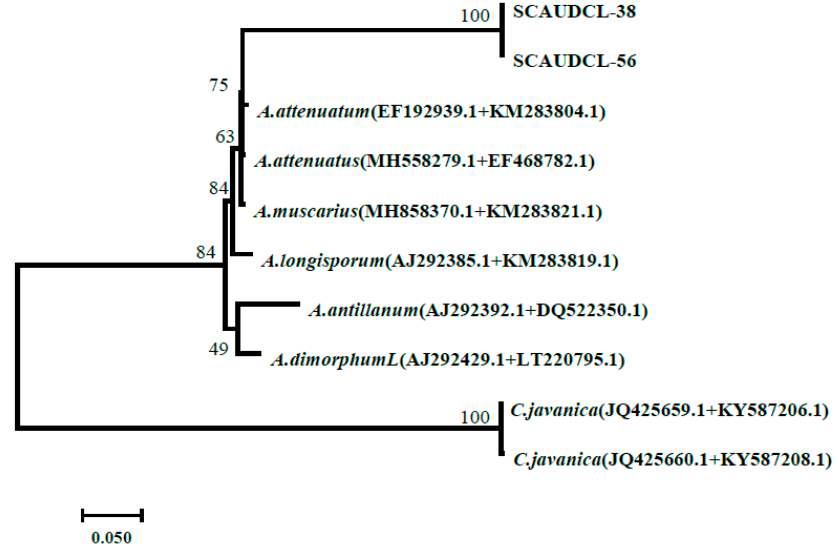
Figure 2. Majority rule consensus phylogram from the Maximum Likelihood (ML) tree based on the sequences of the ITS region and of the protein-coding gene translation elongation factor 1 alpha. ( EF 1- α ) for two A. attenuatus isolates (SCAUDCL-38 isolate, SCAUDCL-56). C. javanica was used as an outgroup.